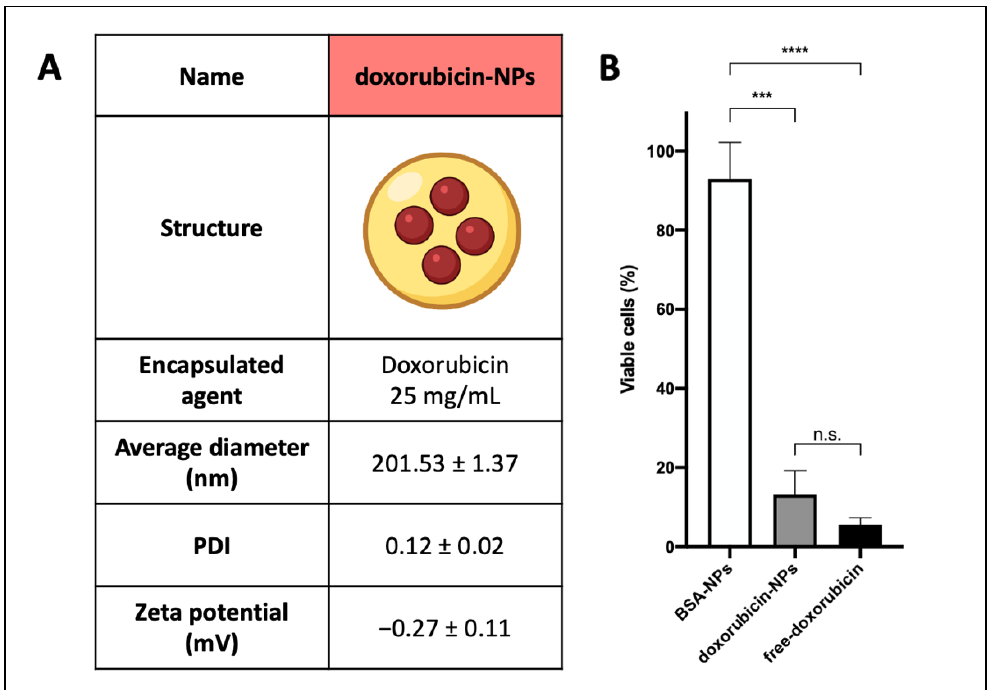
Figure 5. Drug-loaded NPs: ( A ) Physicochemical characteristics of doxorubicin-NPs, which are composed of PLGA-PVA polymers and filled with doxorubicin. ( B ) Nalm-6 cells were incubated with free doxorubicin, doxorubicin-NPs, or BSA-NPs for 24 h. Samples were then analyzed by MTT assay. Data are reported as the mean ± SD. p ≤ 0.001 = ***, p ≤ 0.00 01 = ****, n.s. not significant.